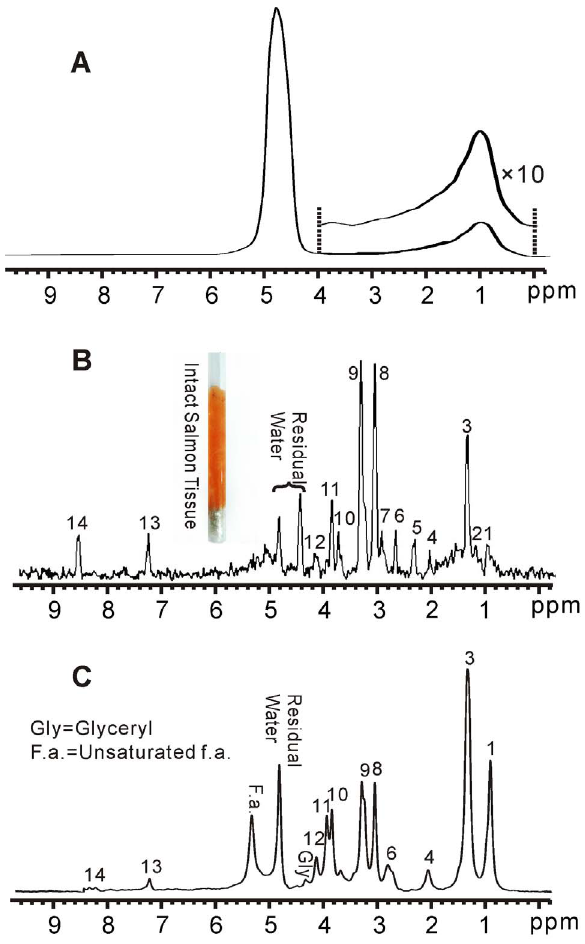
Figure 3. 1 H NMR spectra of intact muscle tissue from Atlantic salmon. (A) Conventional 1D spectrum. (B) 1D iMQC spectrum. (C) 1D